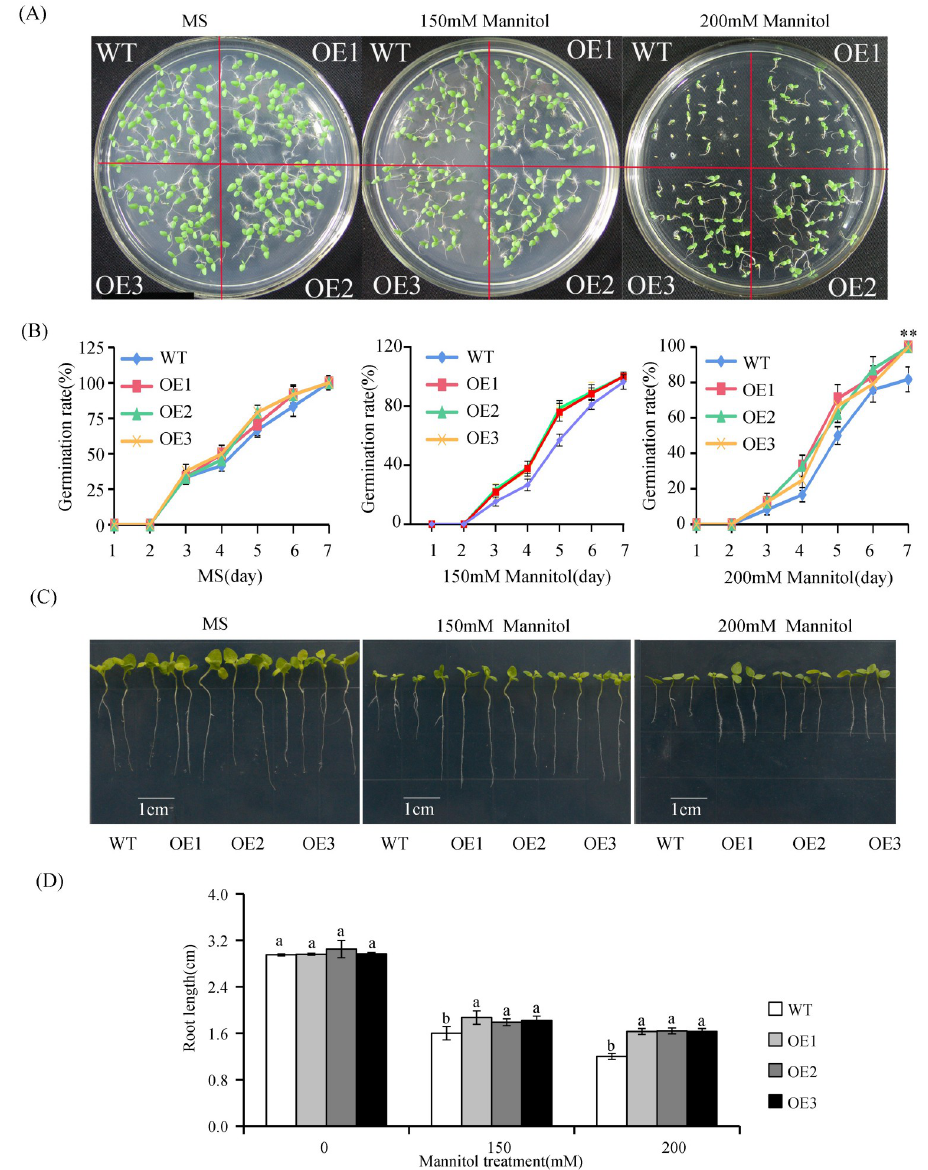
Fig 6. Seed germination and growth of WT and VvASMT1 overexpressing plants under mannitol treatment. (A) The seed germination phenotype, (B) The germination rate, (C) The root phenotype, (D) The root length. The data were presented as the mean ± SE of three independent experiments. Different letters above the columns indicate significant differences (P < 0.05) according to Duncan’s multiple range test.